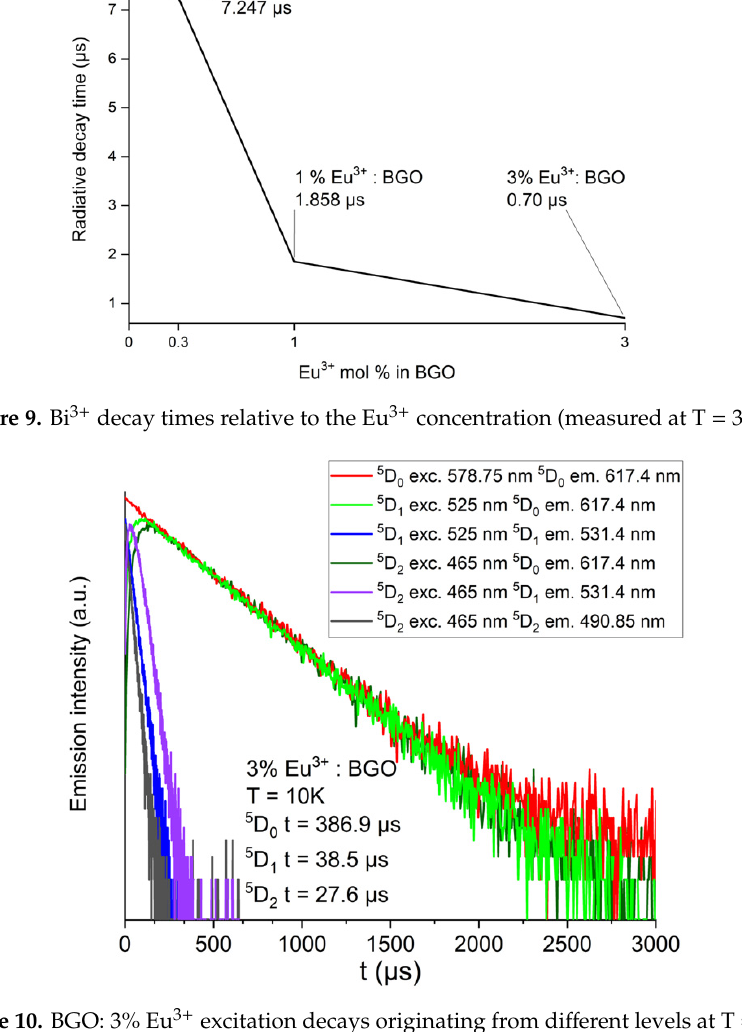
Figure 10. BGO: 3% Eu 3+ excitation decays originating from different levels at T = 10 K.